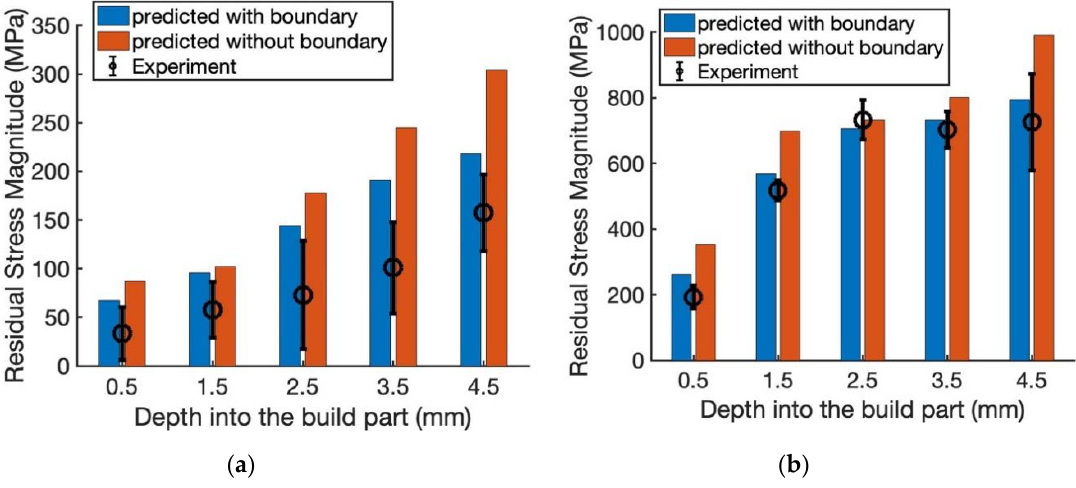
, and hatching space of 100 : ( a ) µ m µ m